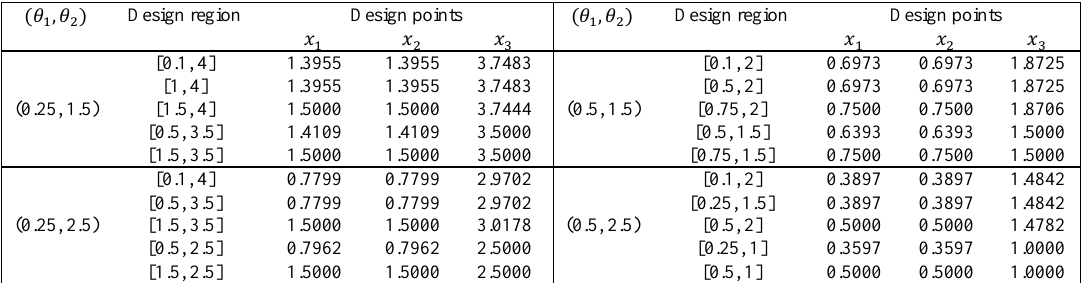
𝑤 = 0.15, 𝑤 = 0.25, 𝑤 = 0.60 1 2 3